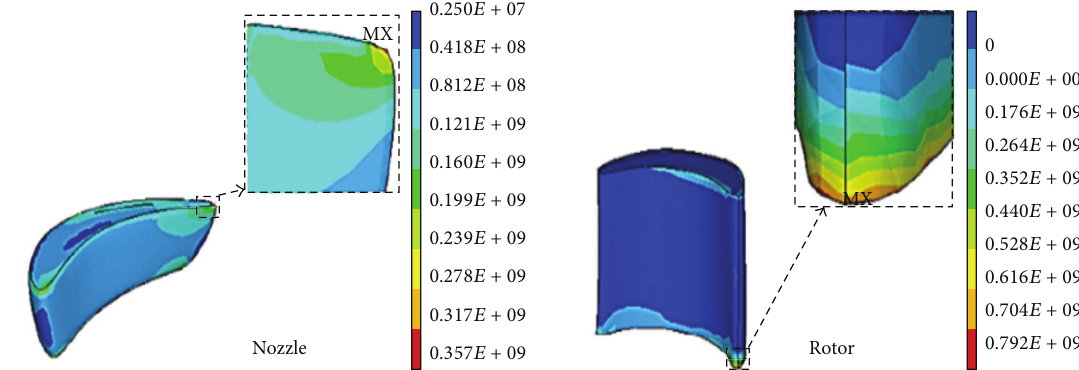
Figure 9: Von-Mises stresses contours on the components, units in